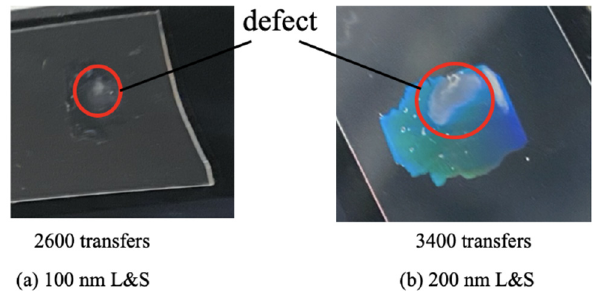
Figure 7. Images of a defect of the ( a ) 100 nm L&S and ( b ) 200 nm L&S transferred patterns.